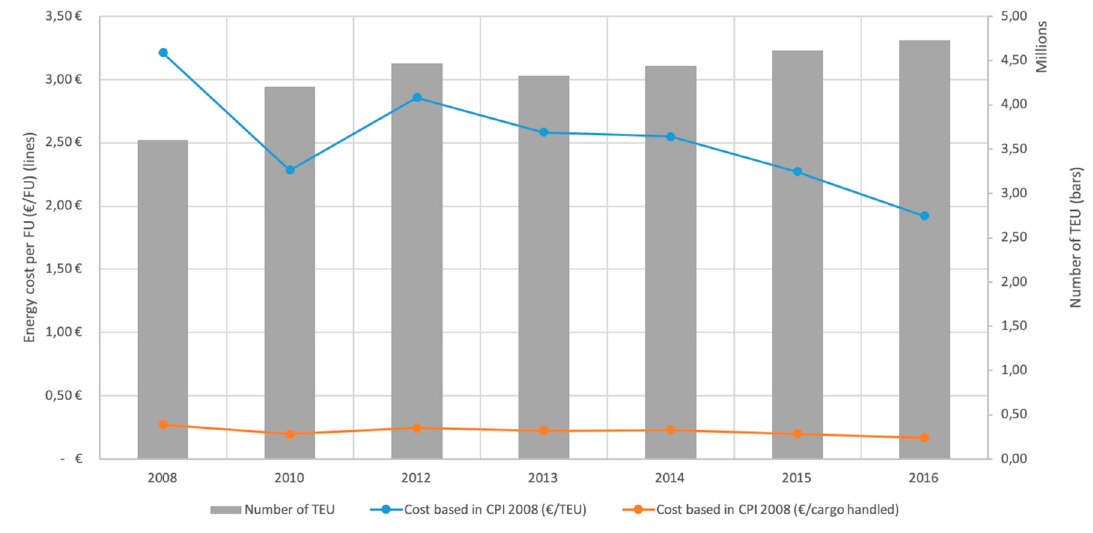
Figure 10. Cost Figure 10. Cost variation.